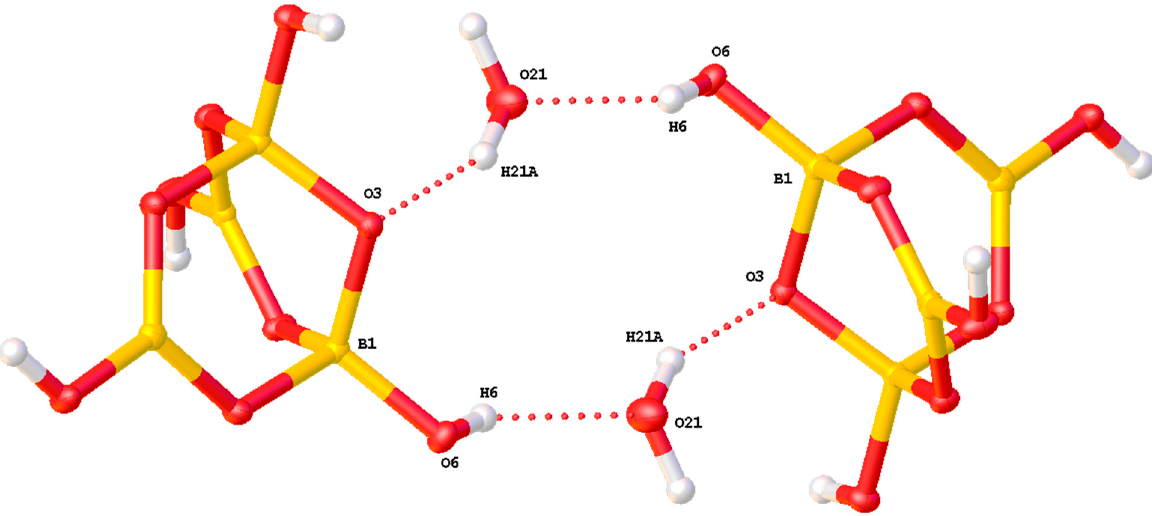
Figure 6. Drawing of the R 44 (12) ring, {O6-H6 … O21-H21A … O3 ′ -B1 ′ -O6 ′ -H6 ′ … O21 ′ -H21A’ … O3-B1-}, in trans - [Ni(NH 3 ) 4 (H 2 O) 2 ][B 4 O 5 (OH) 4 ] . H 2 O ( 1 ).